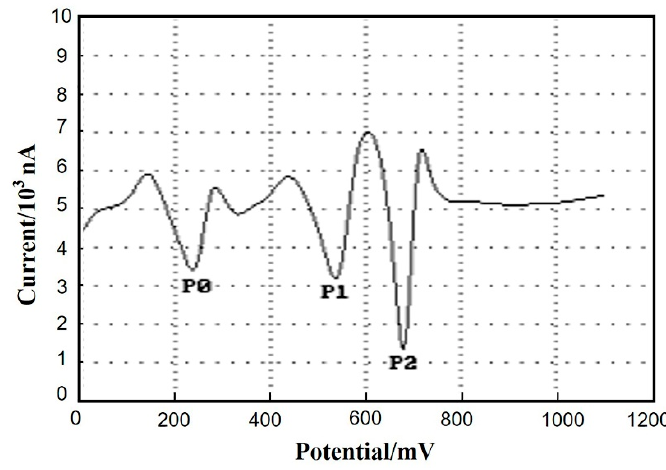
Figure 8. The SDLSV of DA (1 × 10 − 5 mol/L) on the Cu 2 O-RGO/GCE in the presence of AA (1 × 10 − 5 mol/L), and UA (1 × 10 − 5 mol/L). P 0 , P 1 , and P 2 denotes the peak potentials of AA, DA, and UA, respectively. Scan potential range: 0~1.1 V; scan rate: 100 mV/s; supporting electrolytes: 0.1 M PBS.